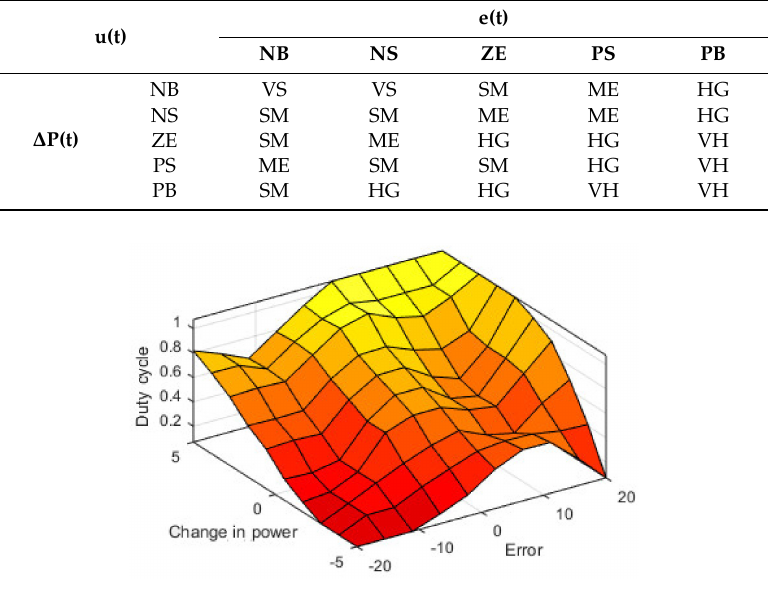
Table 2. Control rules of the VFOFLC.